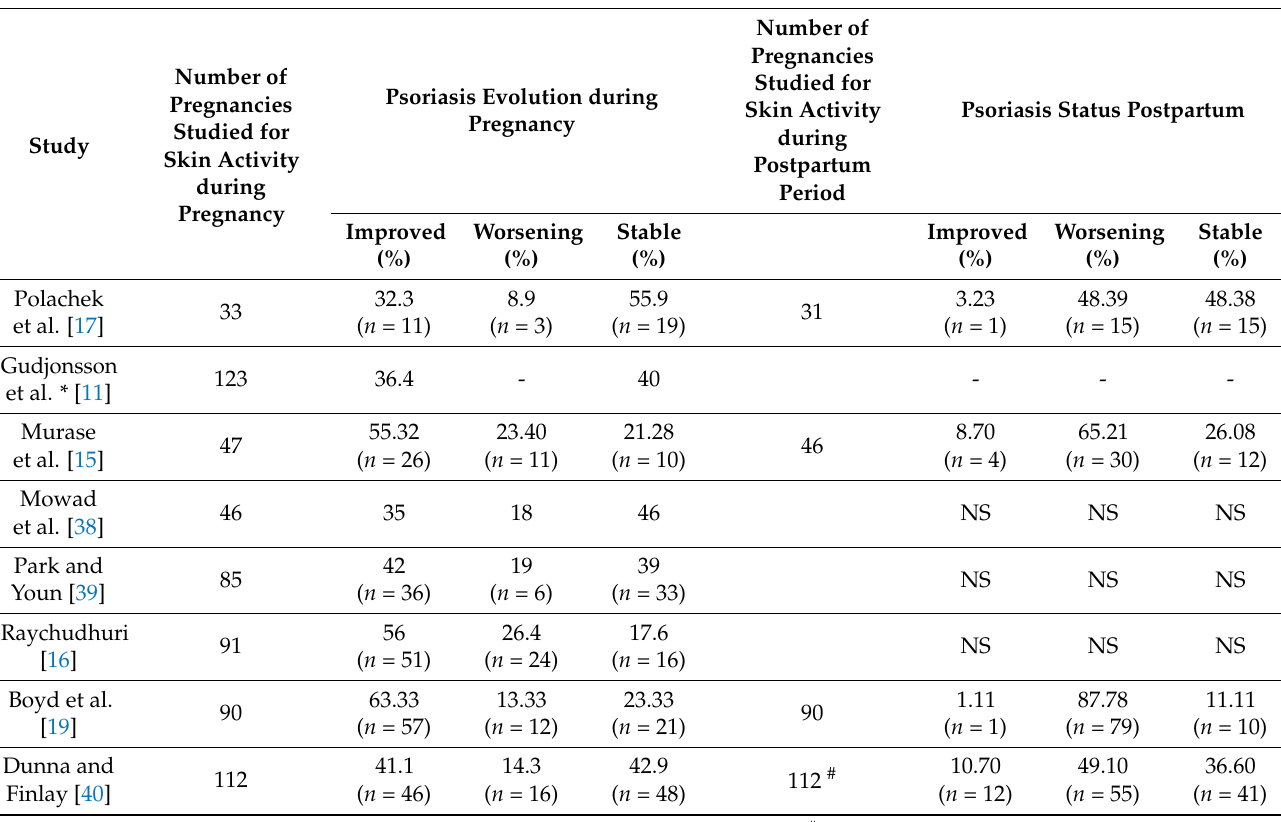
Table 2. Skin psoriatic disease activity during pregnancy and